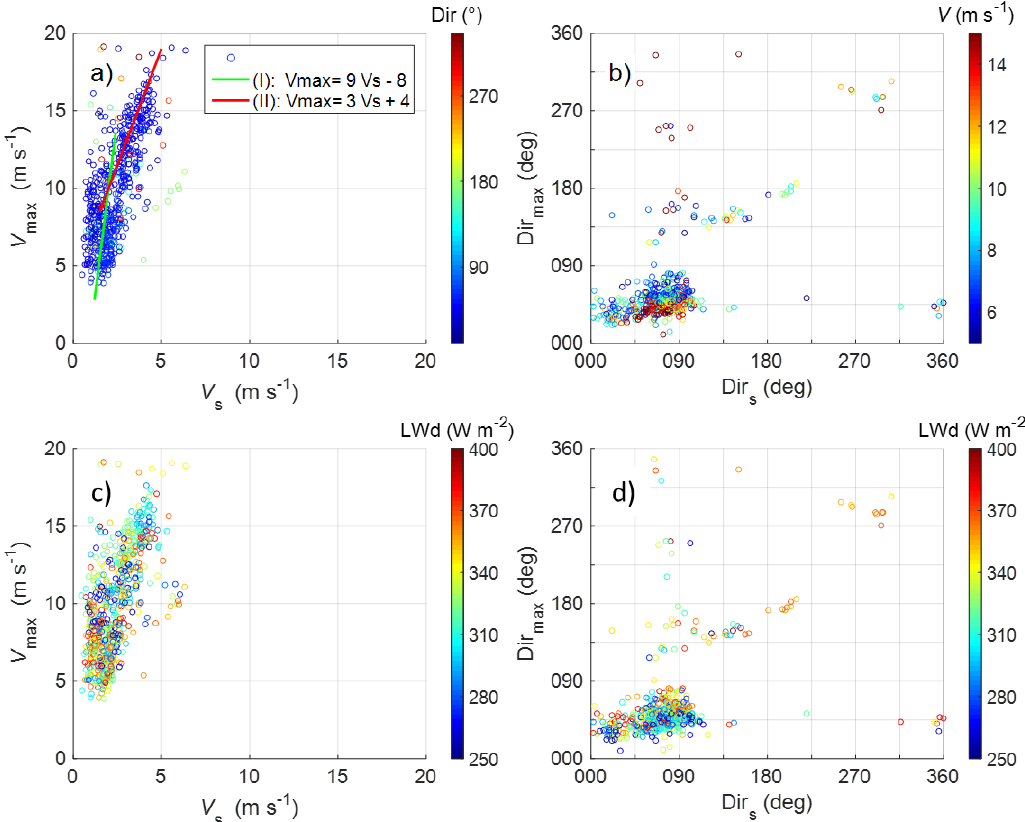
Figure 28. Dependence of the wind ( a , c ) speed V ma x and ( b , d ) direction Dir max at the LLJ core versus the same variables at 5 m ( Vs and Dirs ). Colours in the upper panels indicate wind direction (at a , c ) and speed (at b , d ). Colours in the lower panels indicate the downward longwave radiation.